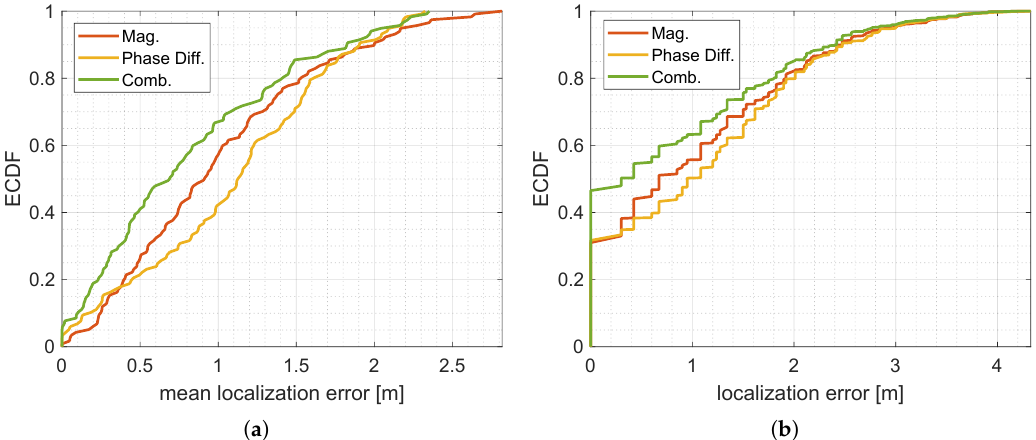
Figure 18. ECDFs for the measured localization error. ( a ) Mean of localization error determined by fingerprinting. ( b ) Localization error determined by